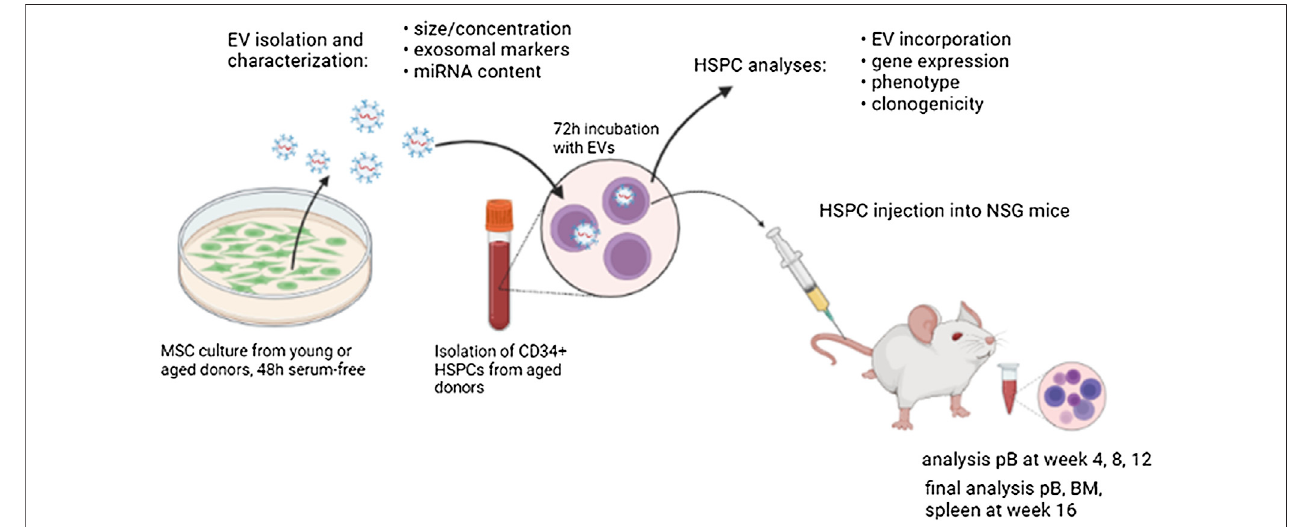
FIGURE 7 | Graphical abstract demonstrating the experimental